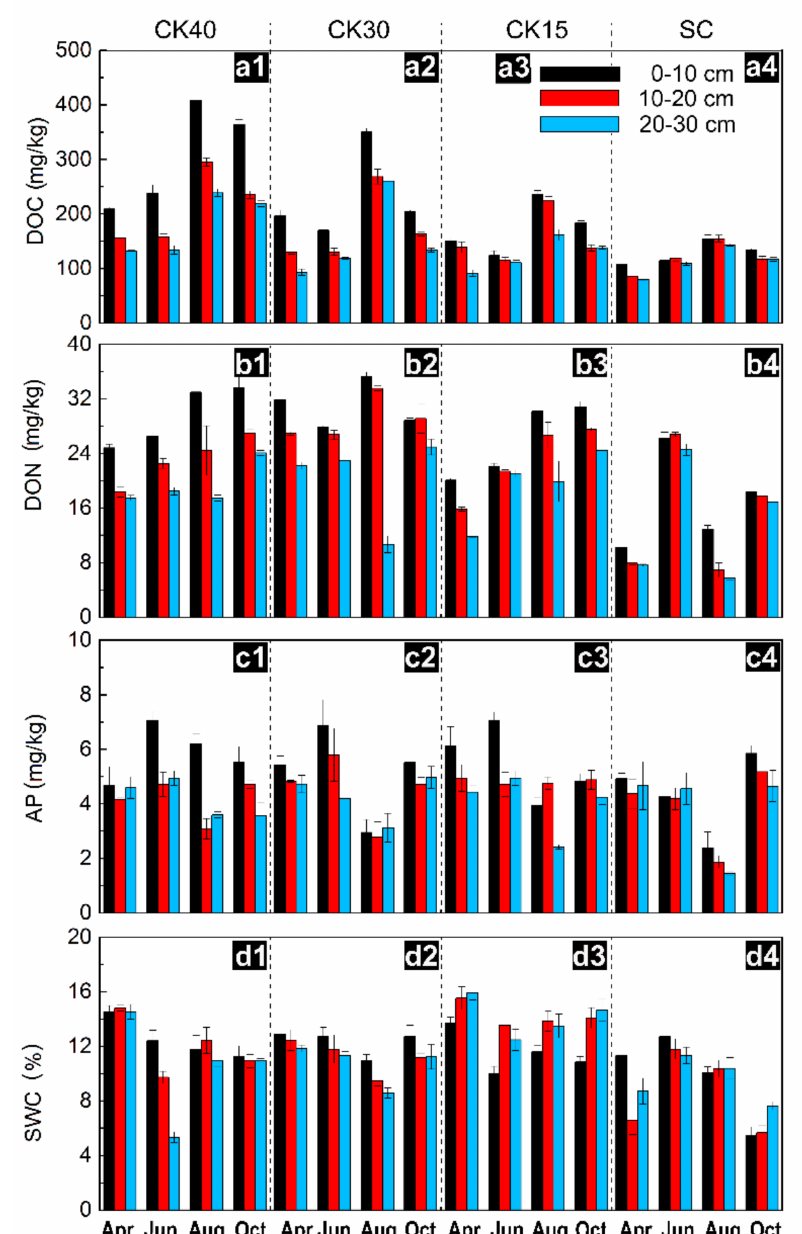
Figure 2. Soil dissolved organic carbon (DOC, a1–a4), dissolved organic nitrogen (DON, b1–b4), available phosphorus (AP, c1–c4), and water content (SWC, d1–d4) in di ff erent soil layers (0–10, 10–20, and 20–30 cm) under di ff erent land-use types in four months. Each bar has nine replicates (three sample lands × three replicate plots). The error bar is the standard error. CK40, CK30, CK20, and SC represent ANOVA results of the significant e ff ects of the di ff erent treatments on the soil properties are shown in Table